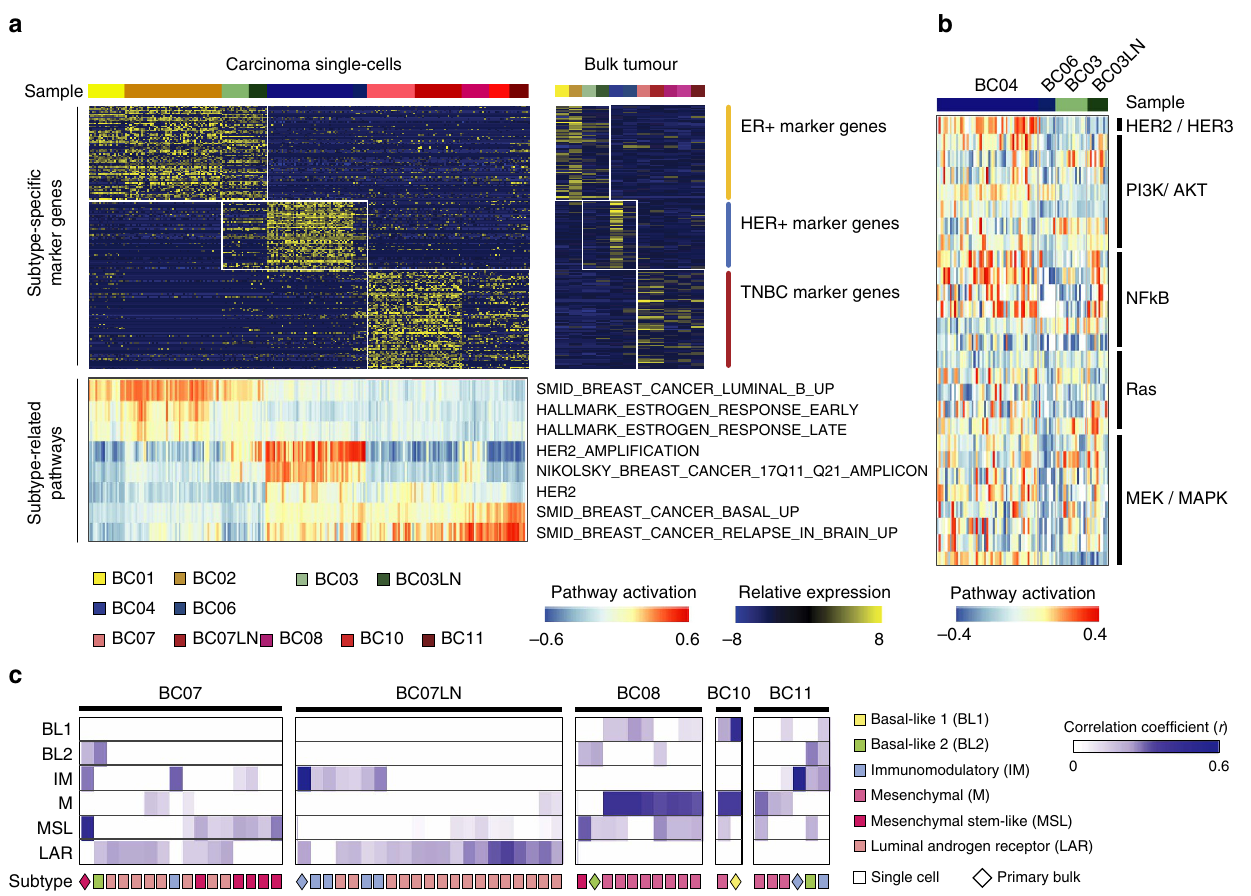
Figure 5 | Subtype-specific gene expression profiling at single-cell resolution. ( a ) LRT based on zero-inflated data and heatmap analysis (upper panels) identifying differentially expressed genes among different subtype tumours at a single-cell level (left) or in bulk (right). GSVA analysis with subtype-related pathways also indicates differential activation of pathways at a single-cell level (lower panel). ( b ) HER2/HER3 downstream signalling pathways (PI3K/AKT, NF-kB and RAS/MEK/MAPK) are highly activated in BC04 HER2 þ tumour cells. Expression of PI3K and NF-kB pathway genes was upregulated in the lymph node metastasis for BC03 ER þ HER2 þ tumour cells. Pathway activation was determined by the GSVA enrichment score. ( c ) TNBCtype analysis 59 was applied only to TNBC tumours (BC07–BC11), which characterized individual cells as one or more of six different